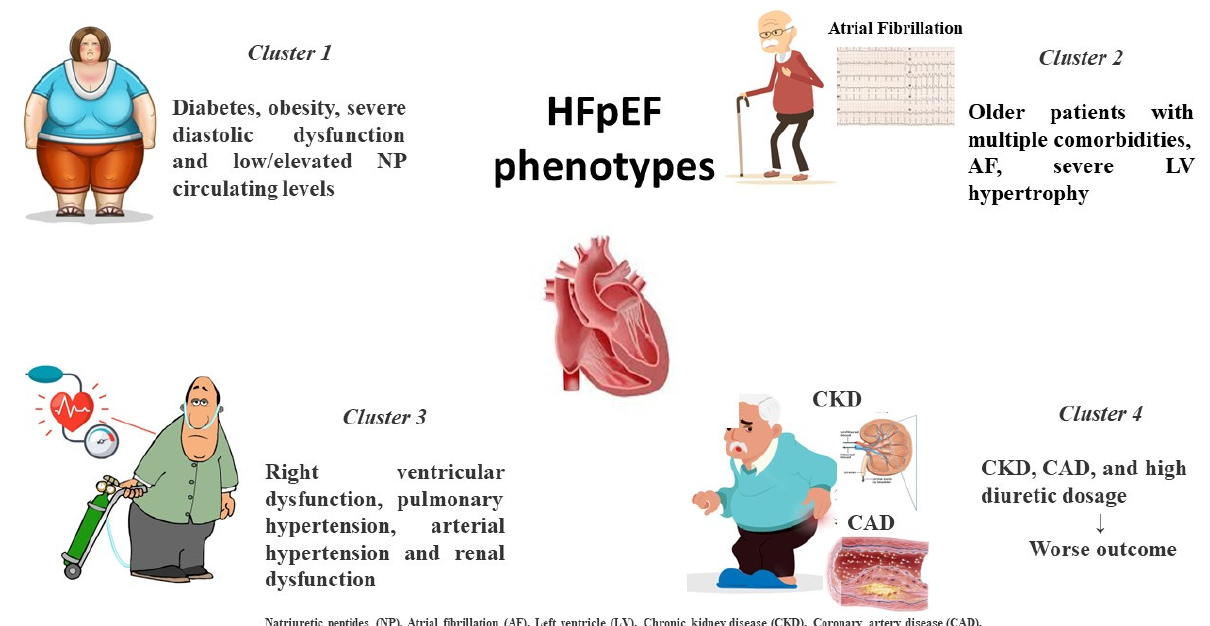
Figure 1. Distinct HFpEF clinical phenotypes based on clinical-presentation-associated metabolic disorders and comorbidities.